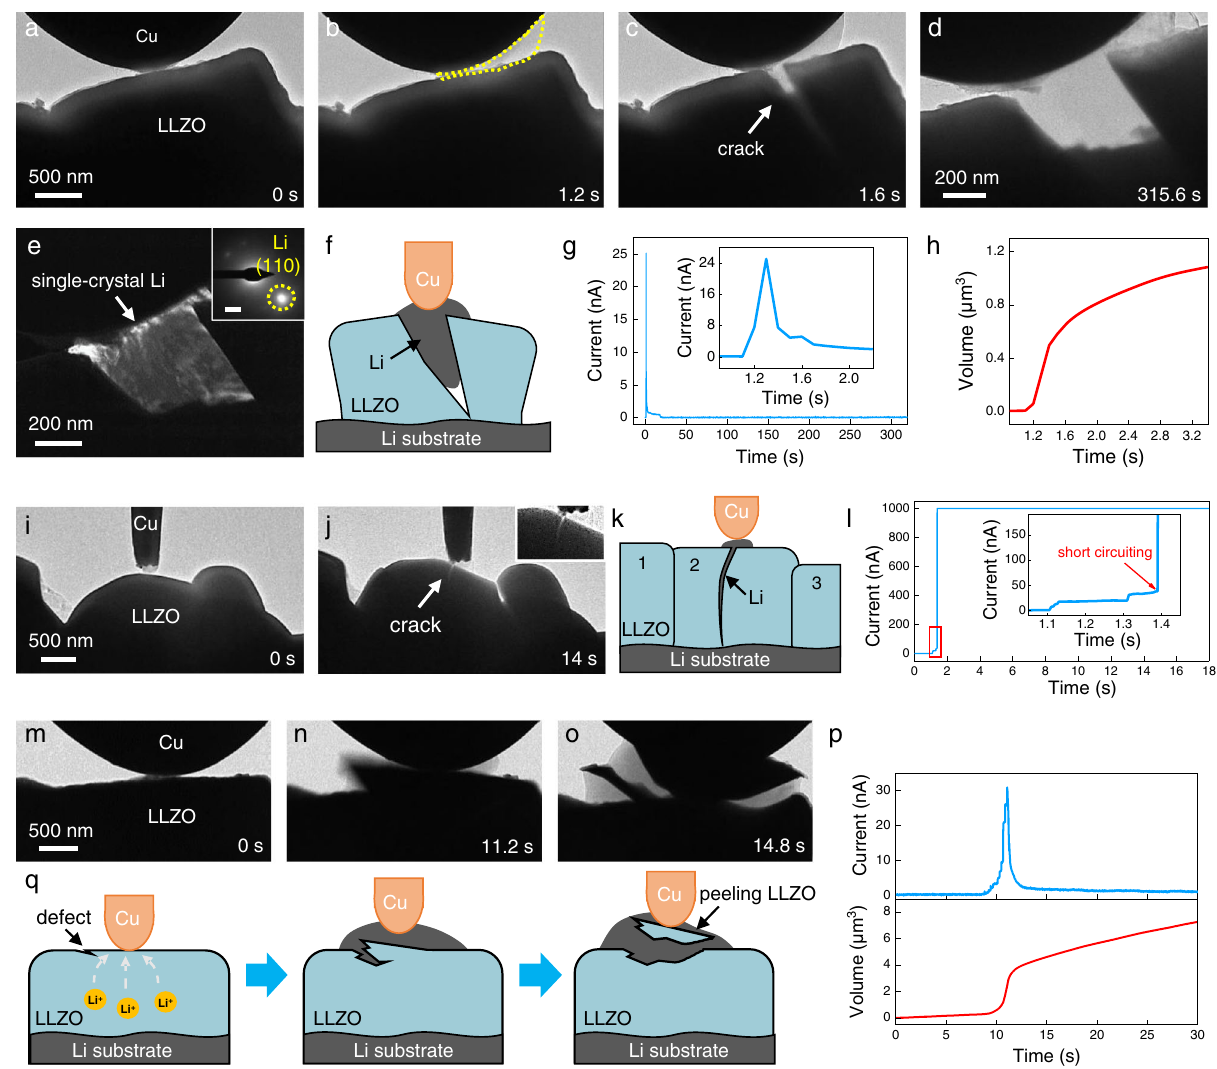
Fig. 3 | Crack initiation and Li penetration in LLZO by Li eruption at the con- strained Cu|LLZOinterface. a – c Lieruption at the interface to crack a single LLZO particle. d Thecrackwasfurtheropenedand fi lledbyLi. e DFandthecorresponding SAED (inset) of the fi lled Li. f Schematic illustration of crackopening and Li fi lling in LLZO. g Themeasured I-t curve.Theinsetistheenlargedpro fi leofthecurrentpeak. h The deposition volume change upon Li eruption. i – j Li eruption to pierce and